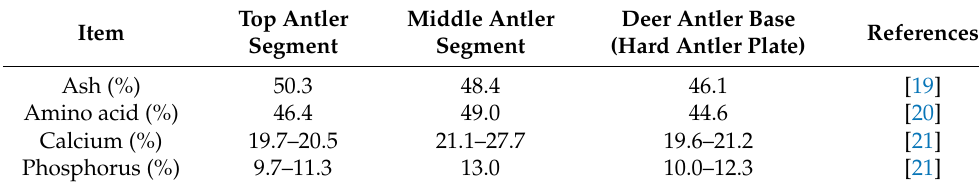
Table 2. Extraction method and biological activity of DAPs.